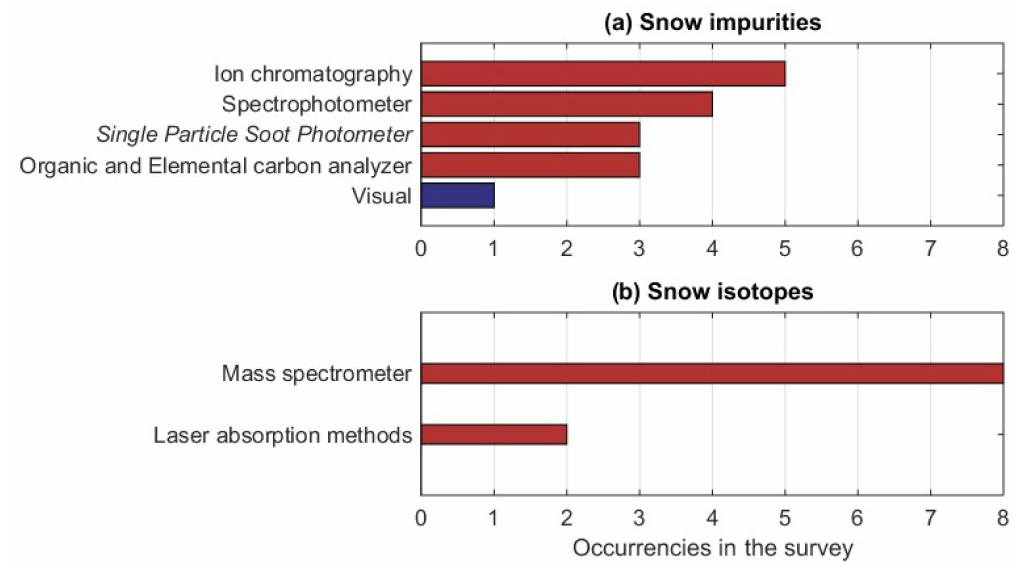
Figure 13. Occurrences of the applied instruments to measure snow impurities ( a ) and snow isotopes ( b ). Different colors denote manual instrument without electronics (blue) and manual instrument with electronics